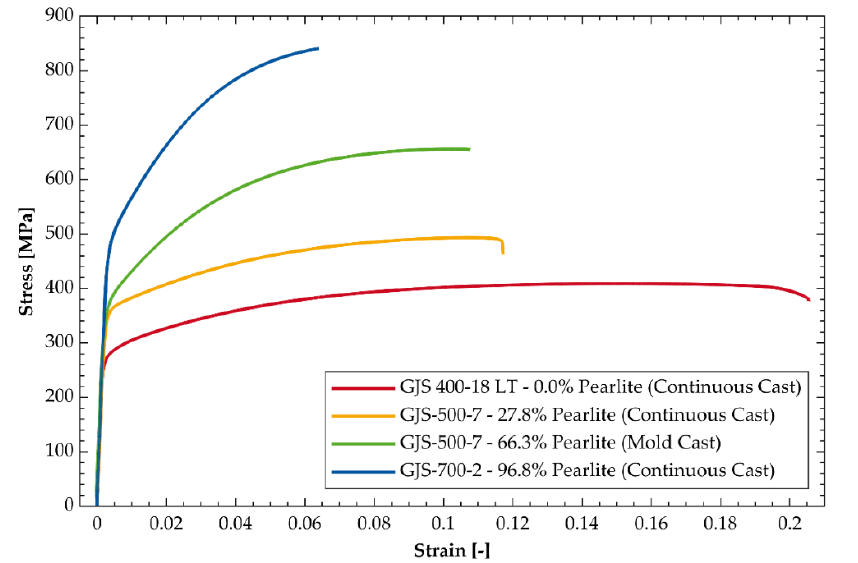
Figure 3. Exemplary stress-strain diagrams for all four materials. Table 3. Results of the tensile tests for each sample.